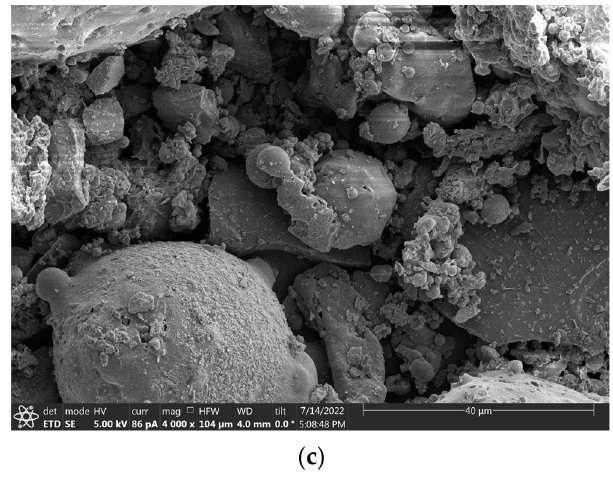
Figure 4. SEM micrograph at 4000 × magnification of particles: ( a ) cement; ( b ) iron tailings; ( c ) fly ash.